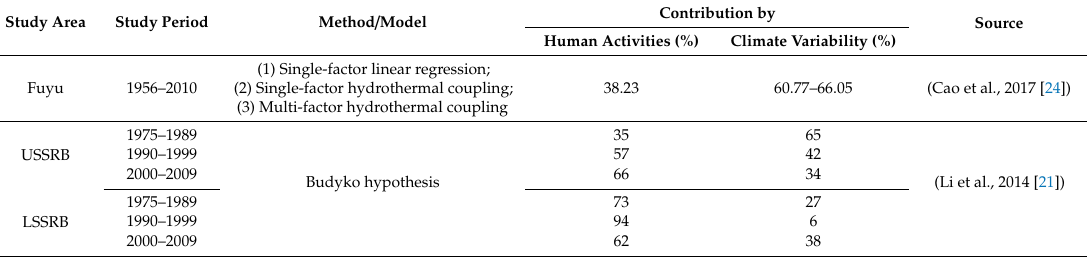
Table 5. Previous attribution studies on runo ff change in